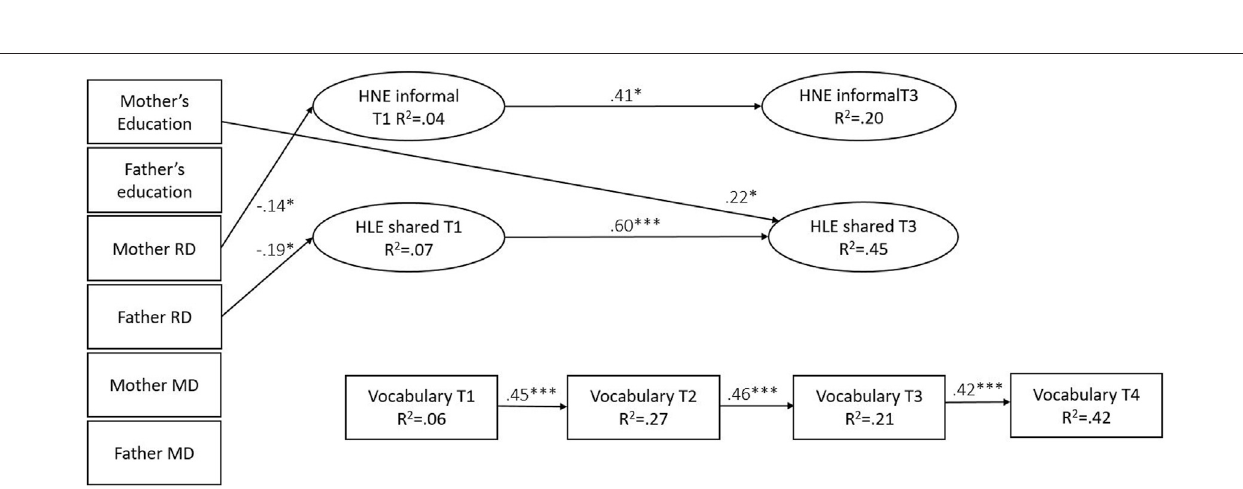
Frontiers in Education |